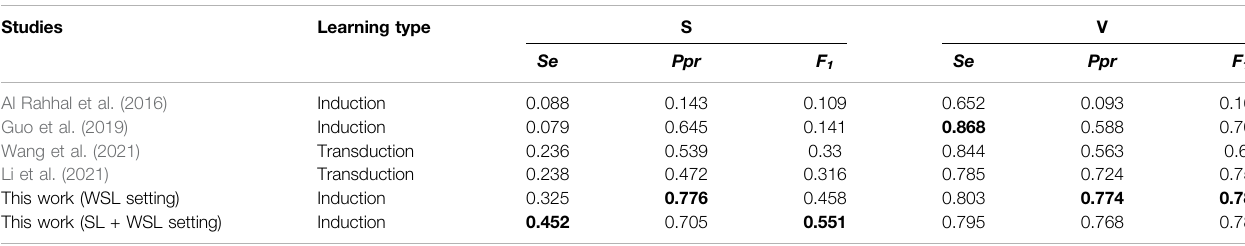
TABLE 5 | Comparison of our method with other studies on the MITBIH-SUP dataset. Studies Learning type